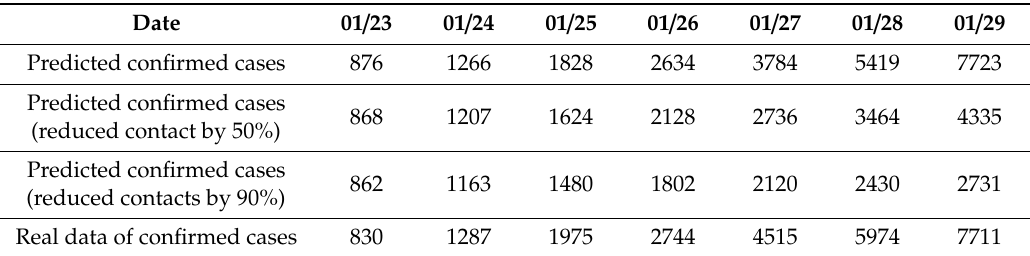
Table 4. Predictions of the confirmed